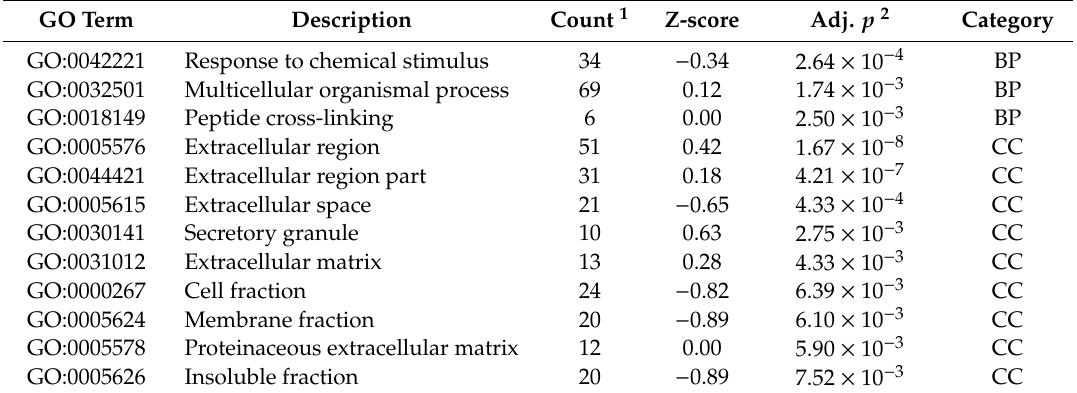
Table 3. GO (gene ontology) term enrichment of DEGs between the asthmatics and healthy controls.